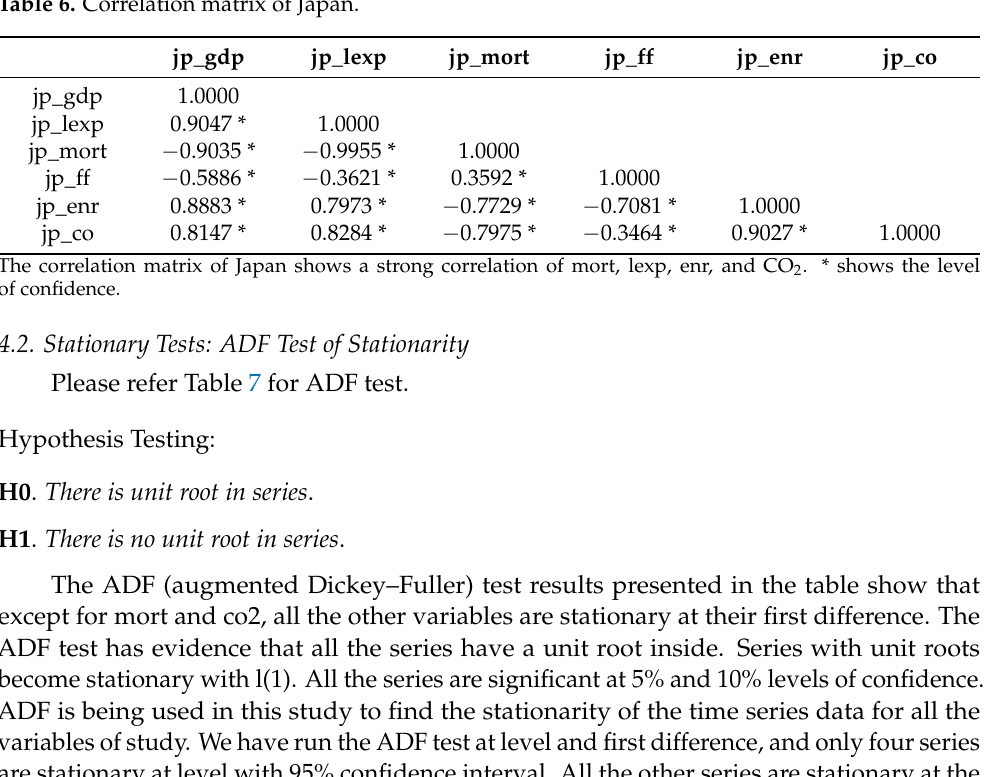
Table 6. Correlation matrix of